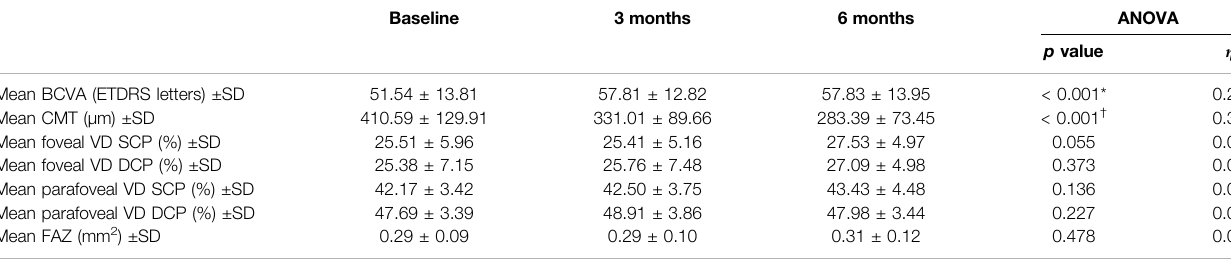
TABLE 2 | Comparison of mean BCVA, CMT, and OCT-A parameters over the SMYL group.